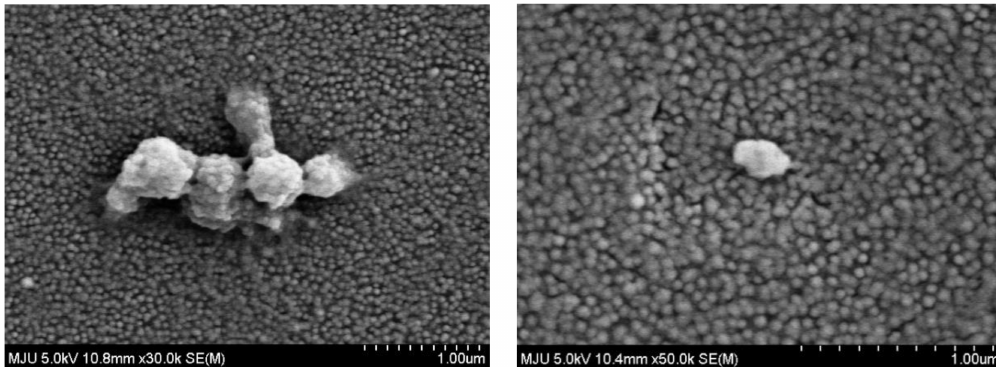
Figure 6. High resolution scanning electron microscope (HR-SEM/EDS) results for the sandwich assay sensor chip with 5 nm Au